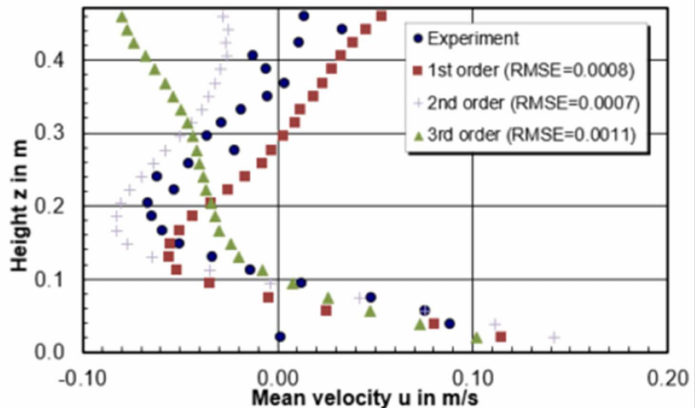
Figure 13. Comparison of horizontal u velocity in a vertical section through the center of the circulation region and RMSE between CFD modelling and